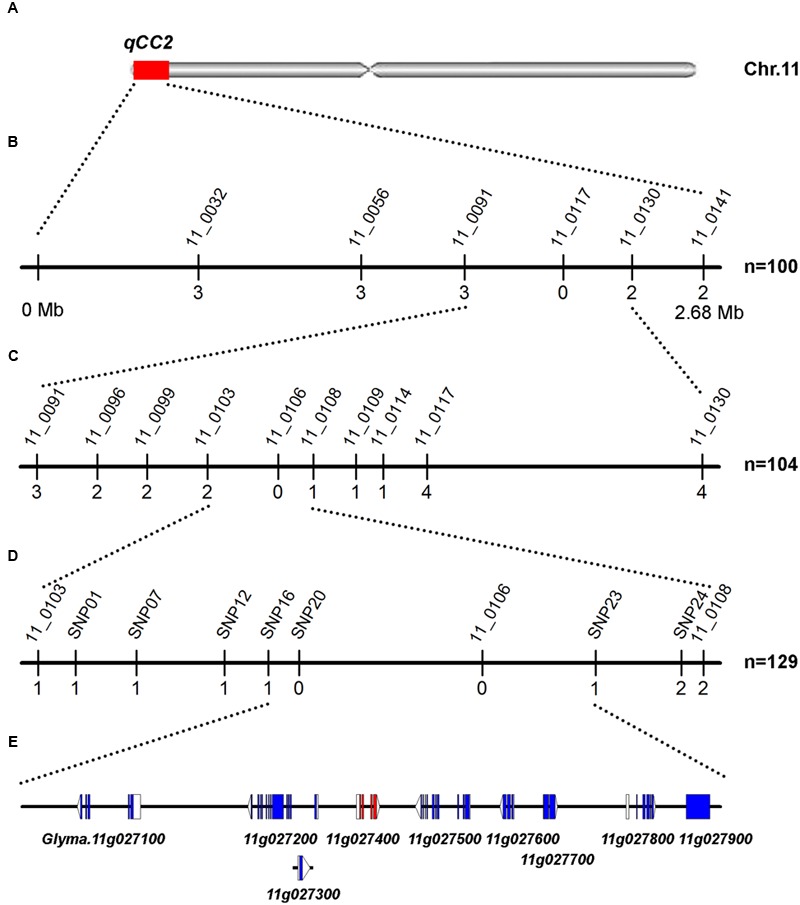
Mapping and fine mapping of the qCC2 locus. (A) Chromosomal location of qCC2 identified by NGS-based BSA method on chromosome 11. (B) Coarse mapping of qCC2 locus. Vertical lines indicate polymorphic markers. Names of markers are shown above the line and the number of recombinants between qCC2 and each marker is shown below the line. (C,D) Fine mapping of qCC2 with genotyping data from newly developed polymorphic markers. (E) Candidate genes in the fine-mapping region. Blue/purple rectangles, blank rectangles, and blank triangles represent exons, 5′ UTRs, and 3′ UTRs, respectively.